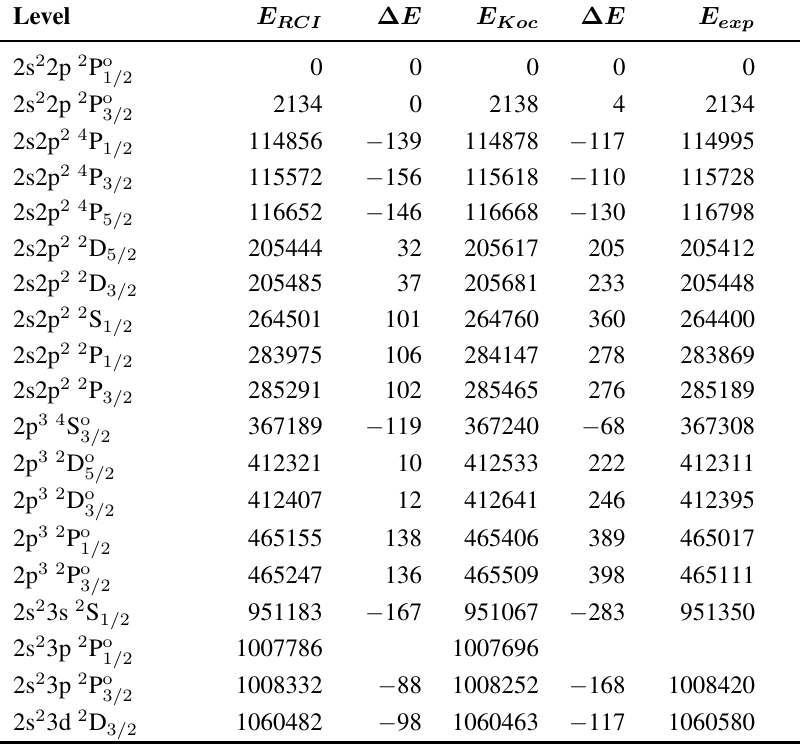
energies in cm − 1 RCI